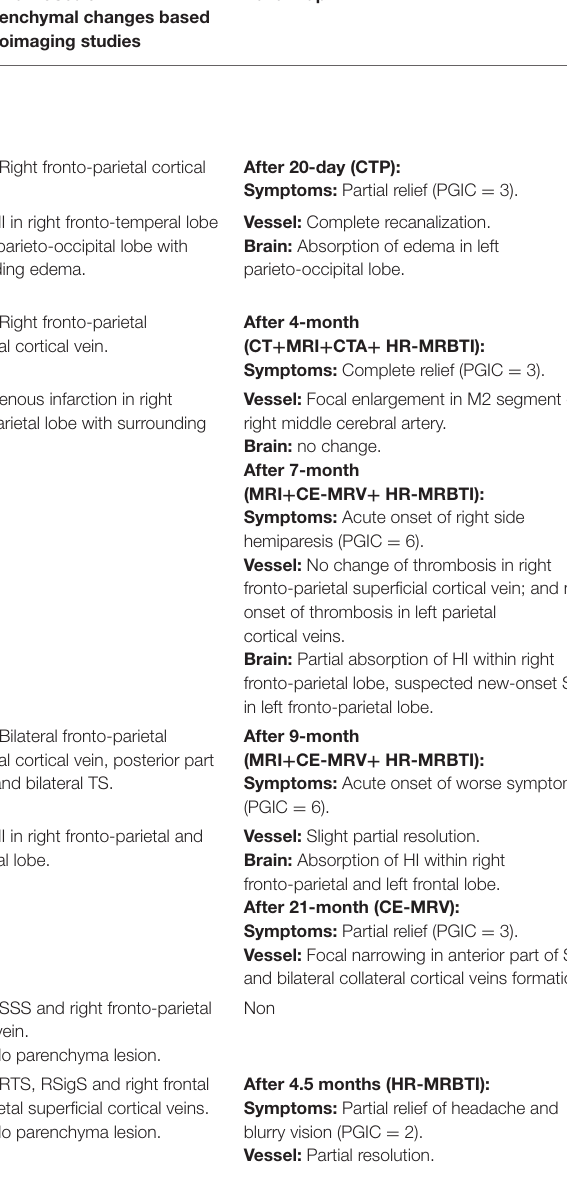
Vessel: RTS, RSigS and right fronto-parietal cortical vein. Brain: right fronto-parietal lobe edema. Vessel: Bil TS and right frontal cortical vein. Brain: No parenchyma lesion.